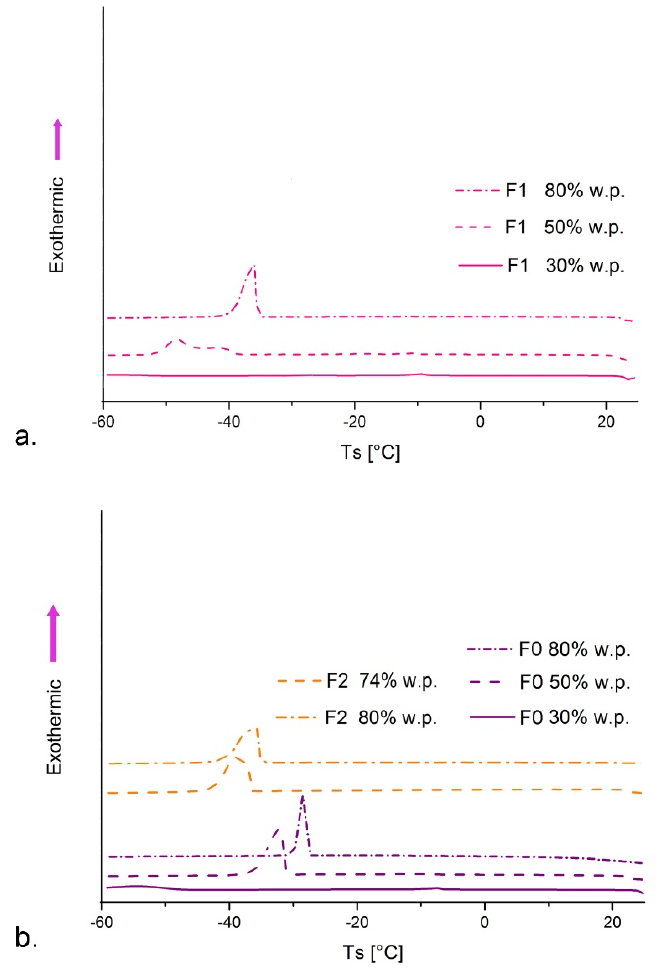
Figure 2. Differential scanning calorimetry (DSC) curves in cooling mode: ( a ) formulations F1 (with cosurfactant 1) and ( b ) formulations F0 and F2 (with cosurfactant 2) with different water phase content (wt%), 7 days after preparation.